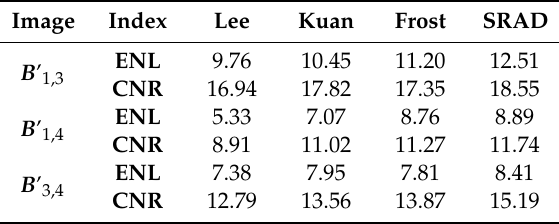
Figure 13. Comparison of filtering results ( a1 )–( c1 ). Lee ( a2 )–( c2 ). Kuan ( a3 )–( c3 ).